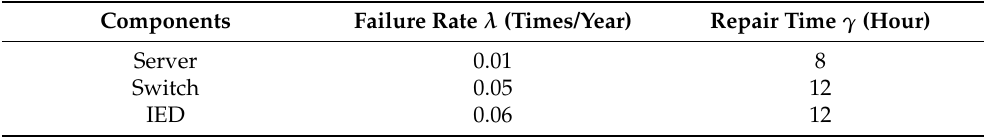
Table 2. Reliability parameters of information components.